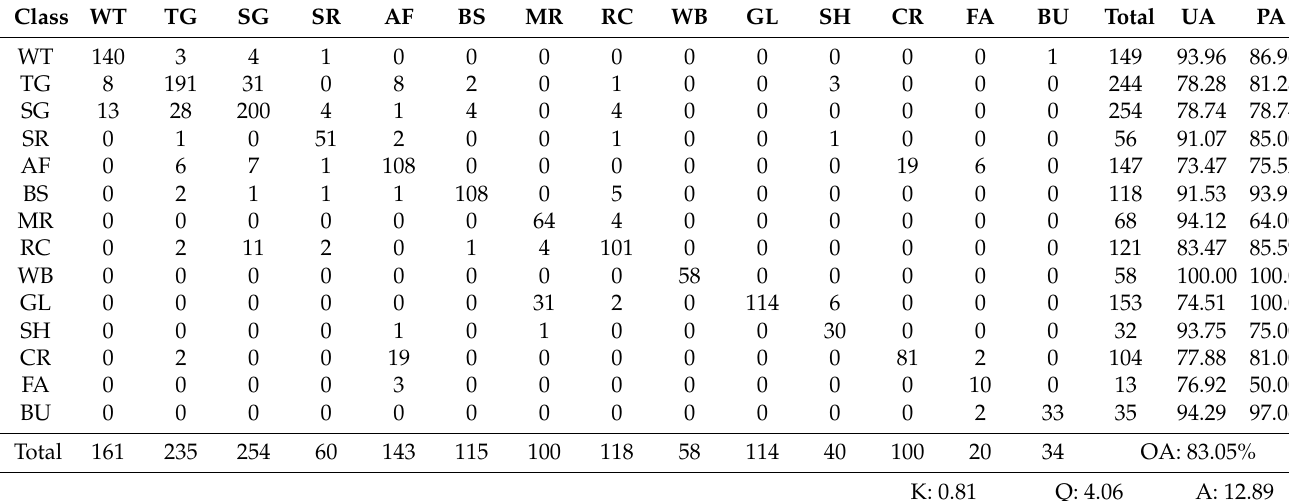
Table 5. Confusion matrix of best